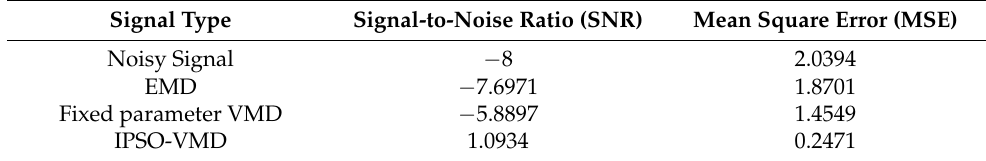
Table 1. Comparison of different